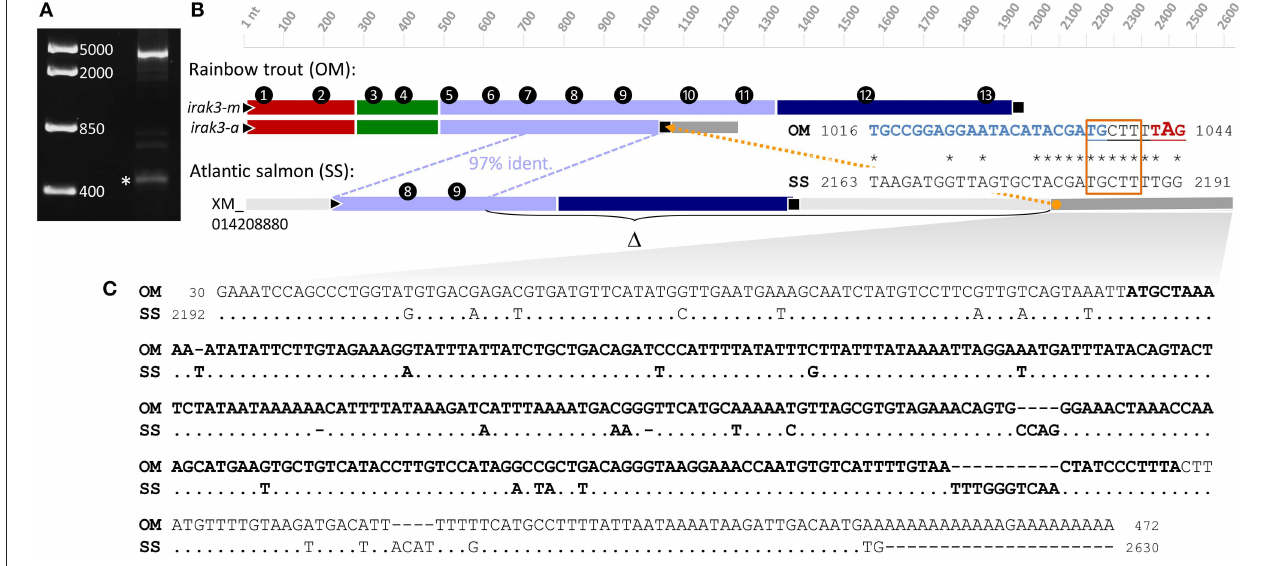
of numerous inhibitory factors ( il1rl1 , tollip , inpp5d , tnfaip3 , cfh , cd59 , a2m , il4/13 , tgfb-2, gpr84 ) mostly at 24 hpi. In